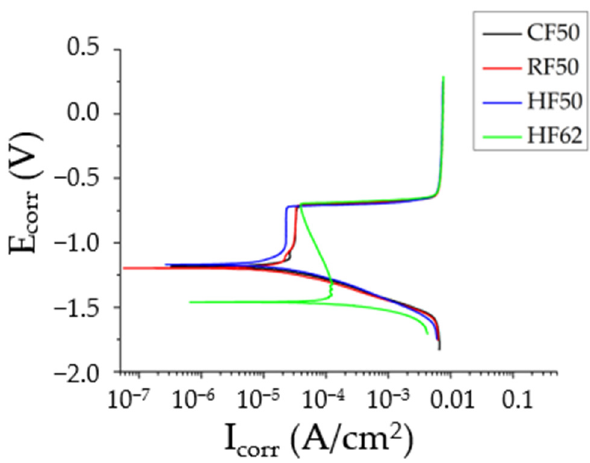
Figure 9. Polarization curves from different samples immersed in a 3.5 wt.% NaCl solution. Table 4. Polarization Curves for Different Samples Immersed in a 3.5 wt.% NaCl